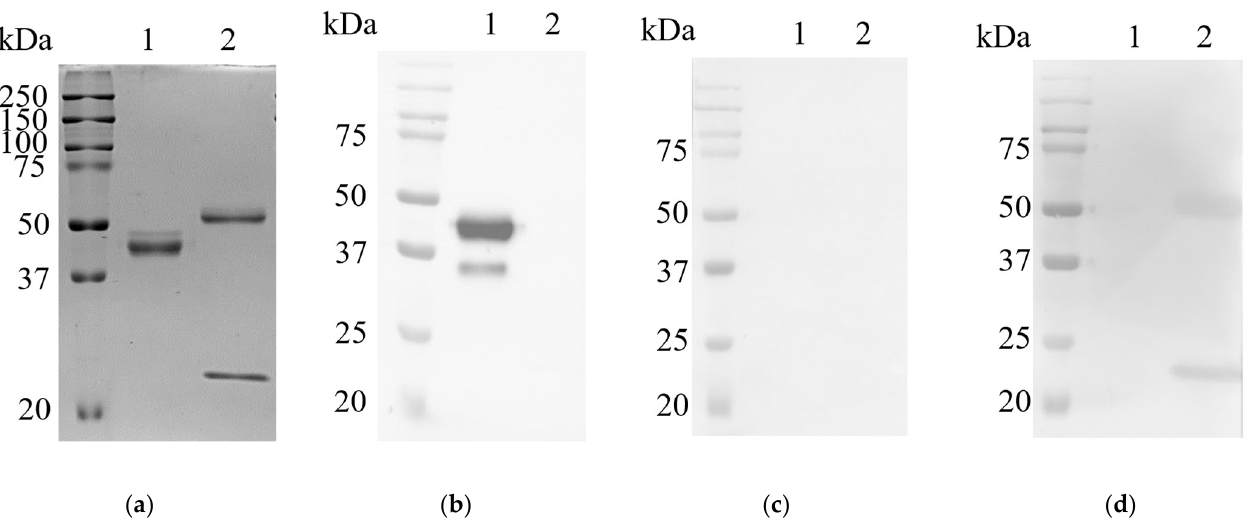
Figure 10. SDS-PAGE and Western blot analysis of camelid heavy-chain-only antibody L19 and a conventional murine monoclonal IgG1 antibody in contrast. The separated antibodies were trans- ferred to a nitrocellulose membrane under semi-dry conditions. Precision Plus Protein™ Dual Color Standard, (BioRad, München, Germany) was used as protein standard molecular weight marker ( a ) both antibodies (each 2 µg) were separated on 10% polyacrylamide gels under reducing conditions and stained by Coomassie staining solution. ( b ) Detection of protein bands performed with HRP- conjugated murine anti-camelid IgG2/3 antibody. ( c ) Detection performed with HRP-conjugated murine anti-camelid conventional antibodies IgG1. ( d ) Detection of conventional murine antibody performed with HRP-conjugated goat anti-mouse IgG (H + L).